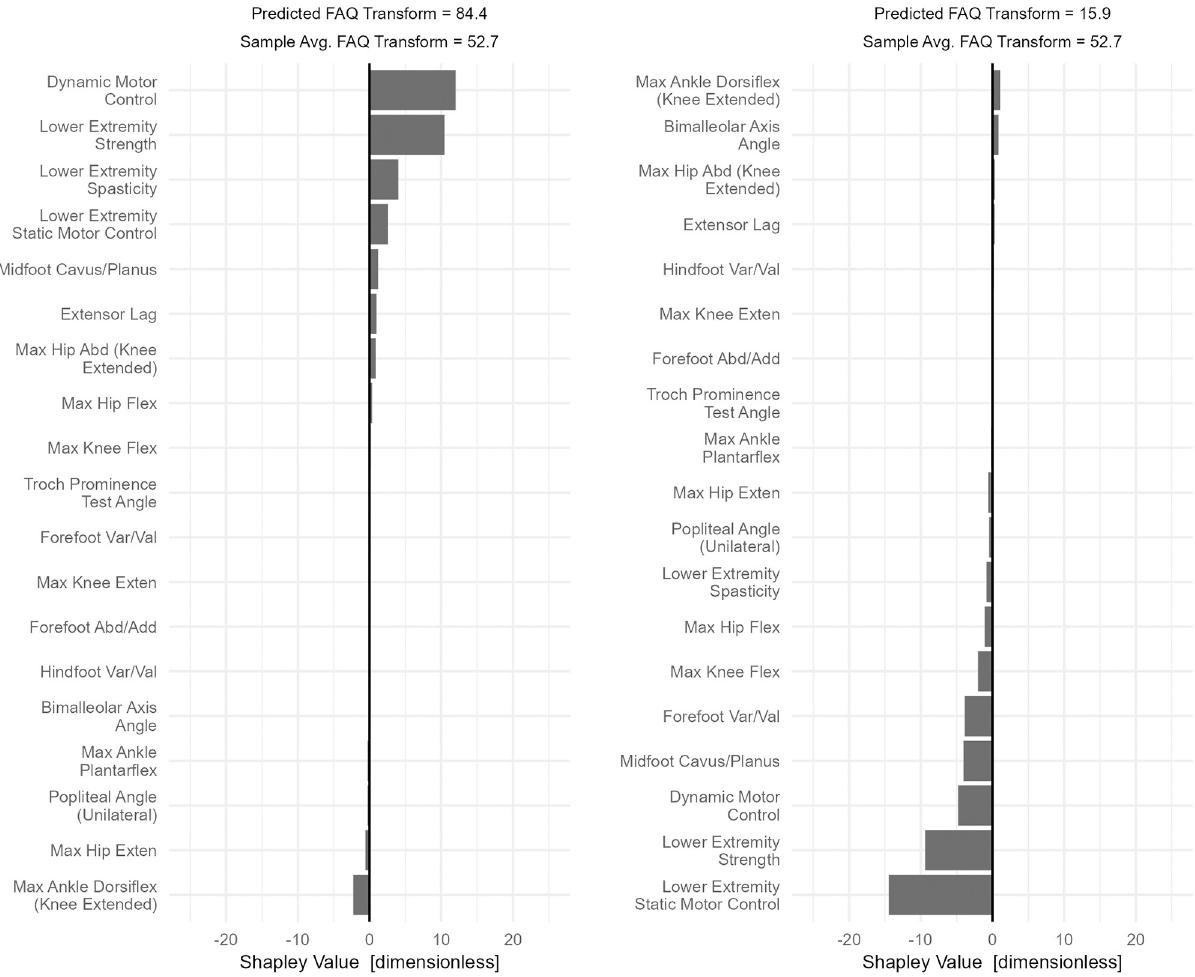
Fig 7. Case studies of Structure and Function effects on the FAQt. Good mobility (high FAQt) is caused by good strength and good motor control, poor mobility is caused by weakness and poor motor control. Strength and motor control are related, but that fact has been accounted for in the chosen adjustment